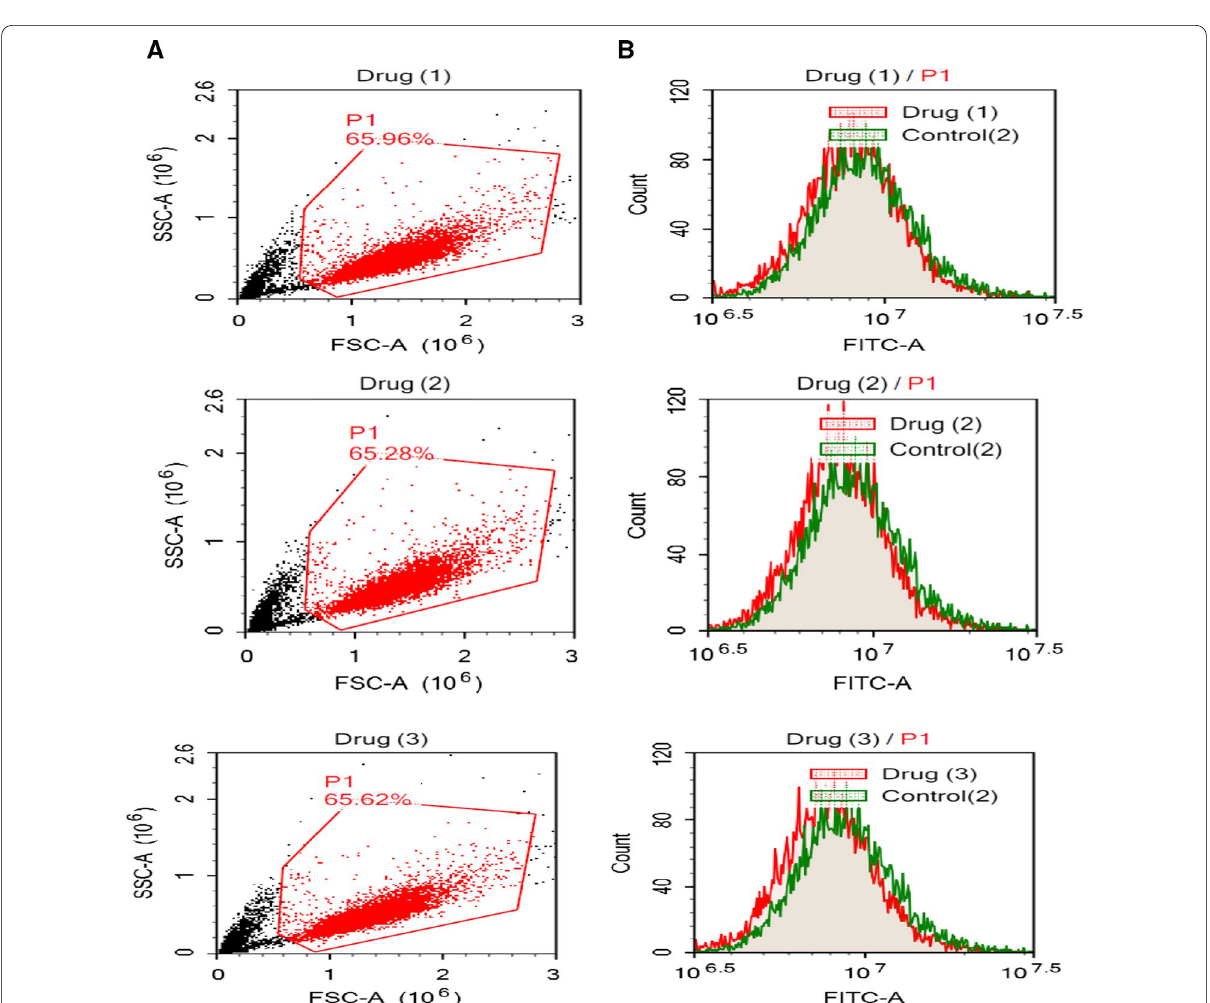
Fig. 8 A Flow cytometric analysis after AO staining. B Histogram profiles of the control and apricot oil group were generated by flow cytometry